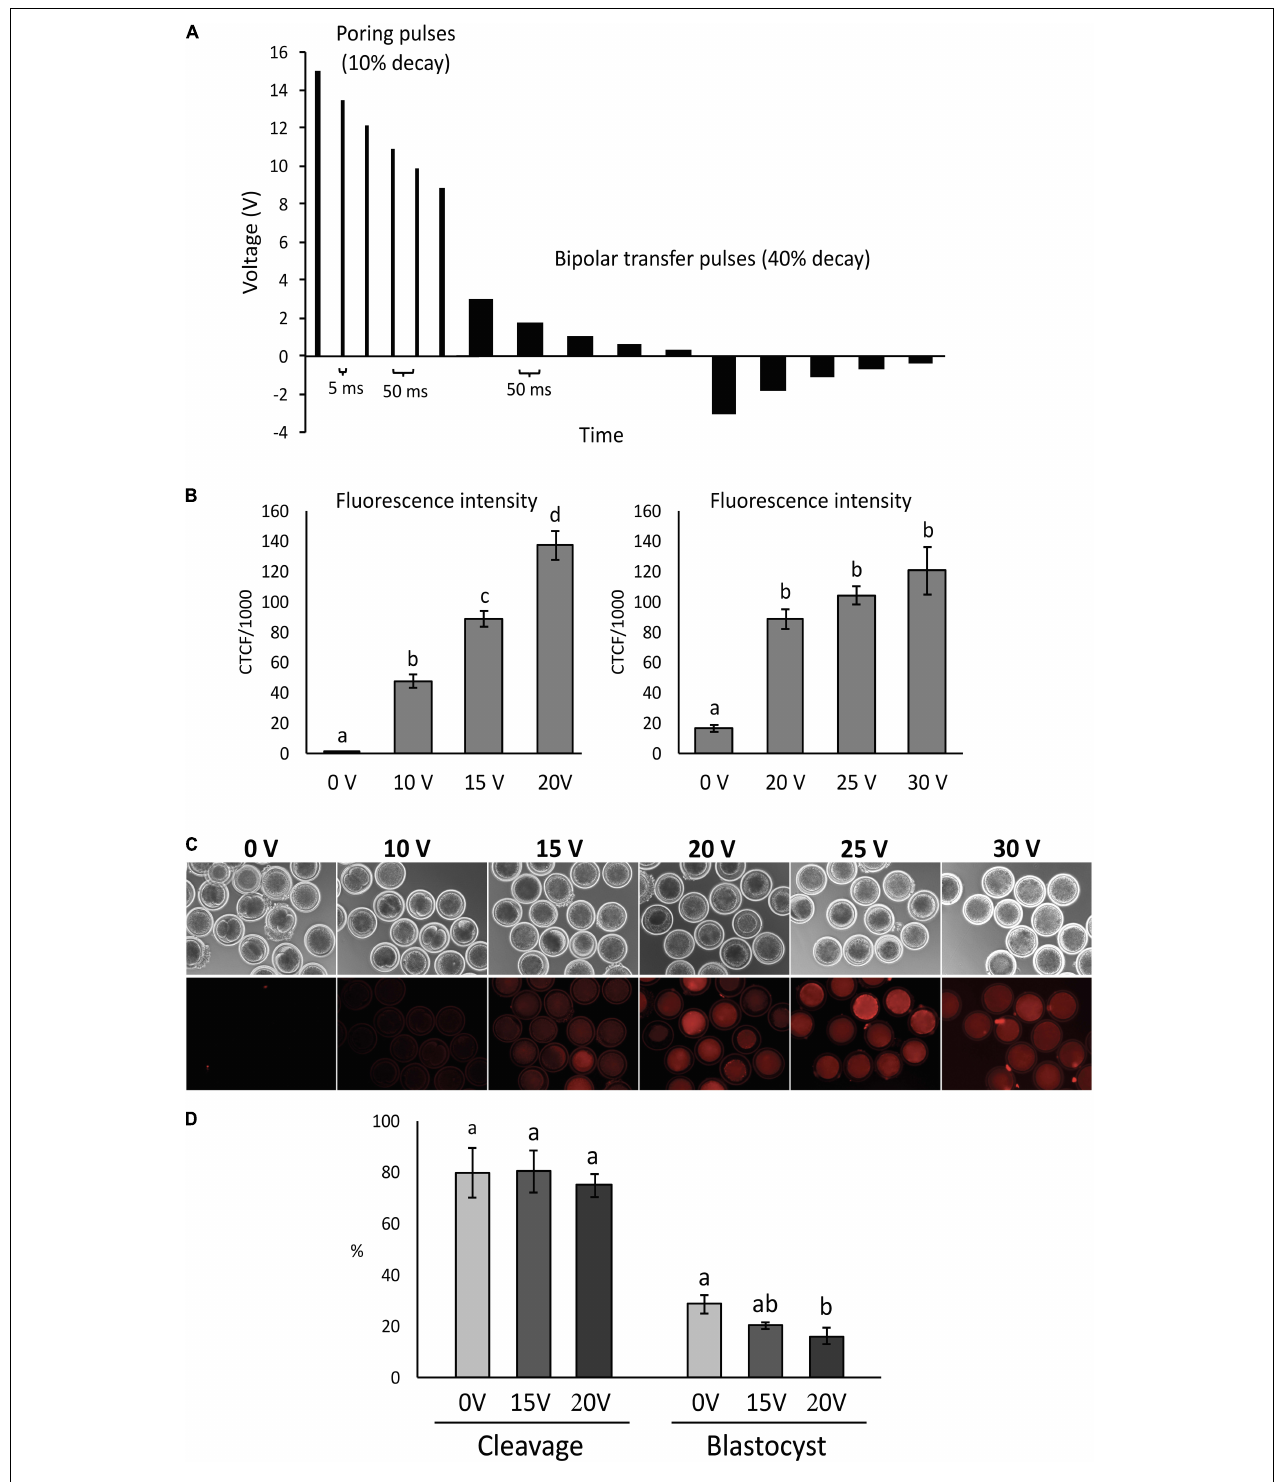
FIGURE 1 | Condition optimization for efficient electroporation of bovine zygotes. (A) Diagram depicting the electroporation settings used in the study. (B) Fluorescence intensity of parthenogenetic bovine zygotes after electroporation in the presence of tetramethylrhodamine-labeled dextran ( n = 54 zygotes). a - d Different letters indicate statistically significant differences ( P < 0.001). CTCF, corrected total cell fluorescence. (C) Representative images of zygotes after electroporation at different voltages. (D) Development of parthenogenetic zygotes after sham electroporation at different initial voltages. a , b Different letters indicate statistically significant Intensity of differences ( P < 0.05). Experiment replicated four times. Sample size per group: 0 V = 114 zygotes; 15 V = 89 zygotes; and 20 V = 84 zygotes.